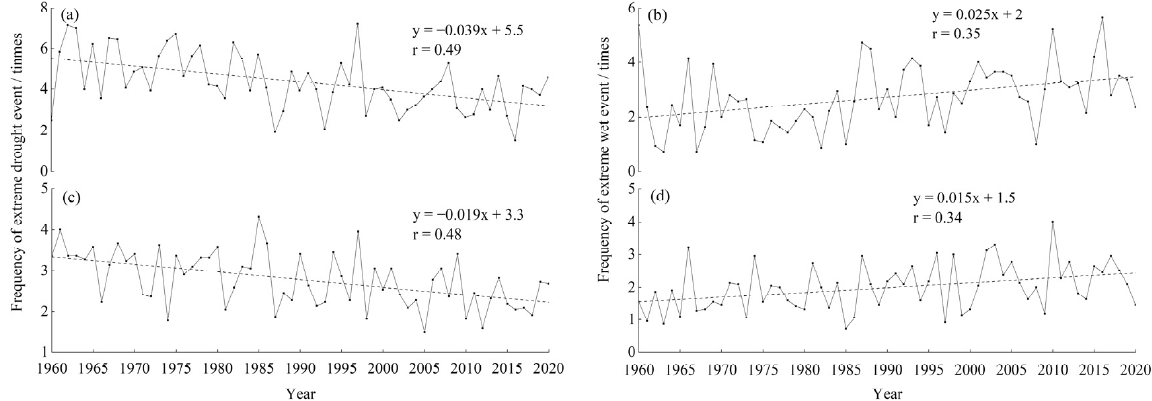
Figure 3. Trend in extreme drought ( a , c ) and wet ( b , d ) events in northern ( a , b ) and southern ( c , d ) Xinjiang from 1960 to 2020.